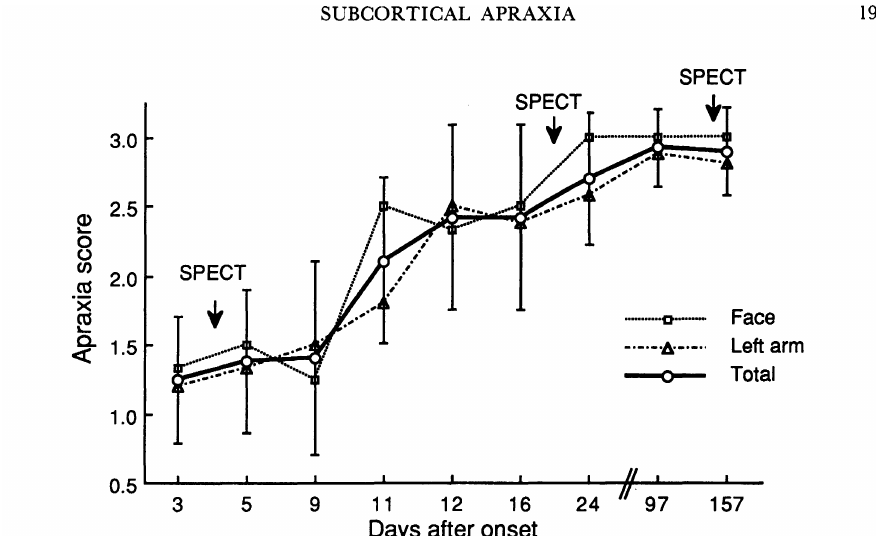
FIG. 3. Course of improvement of oral and ideomotor apraxia as measured by an apraxia score (Kertesz and Ferro, 1984) (3 = good performance, 2 = impaired but recognizable, 1 = poor performance, 0 = no response, unrecognizable or unrelated gesture), with respect to the time from onset of the symptoms. The time of the SPECT studies on the 4th, 19th, and 143rd day is